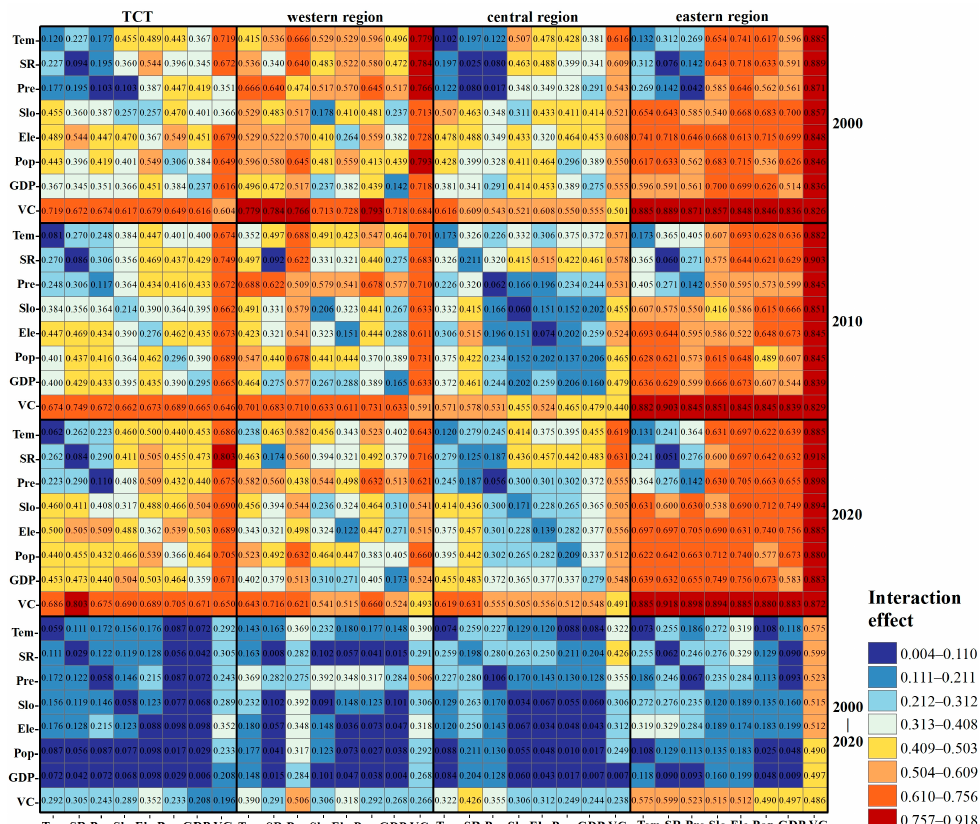
Figure 6. Interaction effect between natural and anthropogenic factors on NPP in 2000, 2010, and 2020, and NPP change trend in the TCT and three regions from 2000 to 2020.